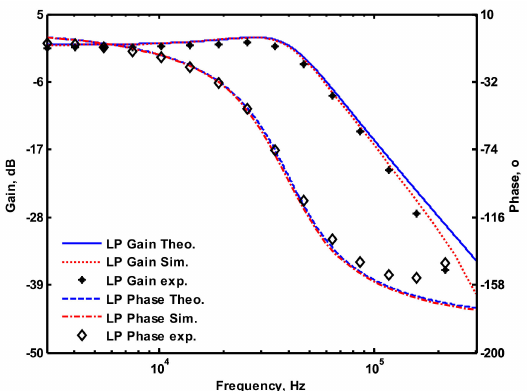
Figure 7. Simulation and experimental results of LP filtering responses at V o1 when V i1 = V in and V i2 = 0.